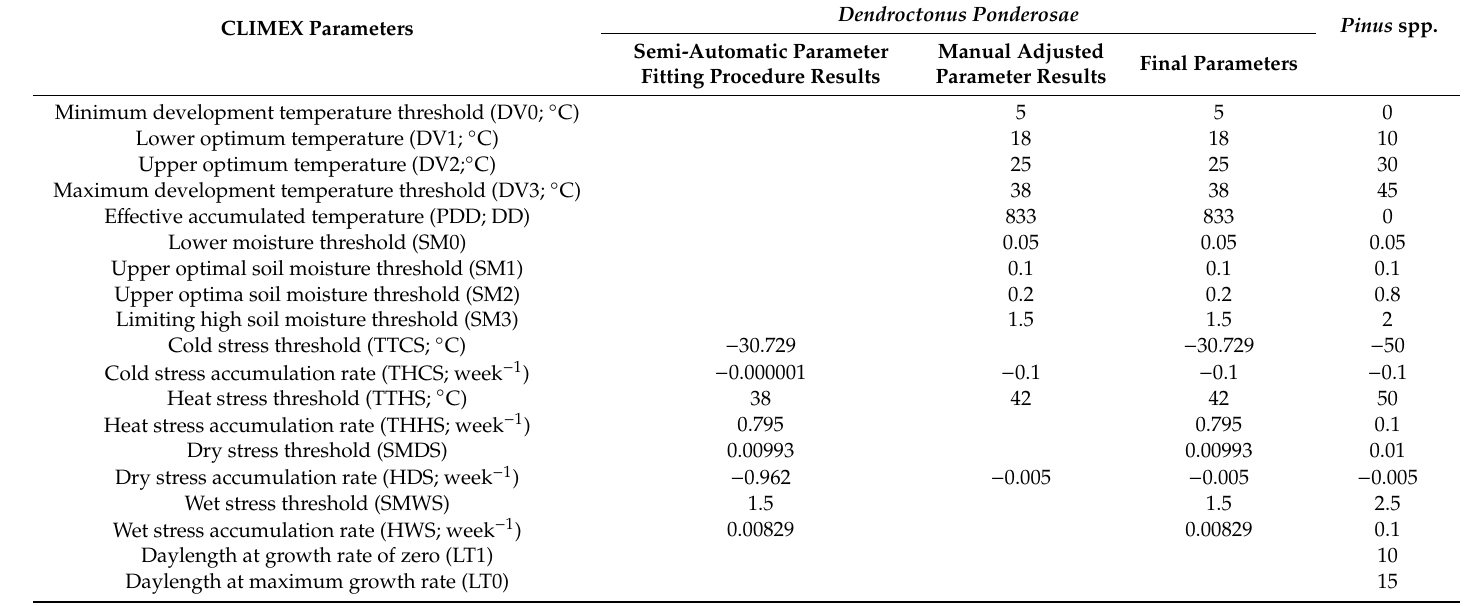
Table A2. CLIMEX parameter values for Dendroctonus ponderosae and Pinus